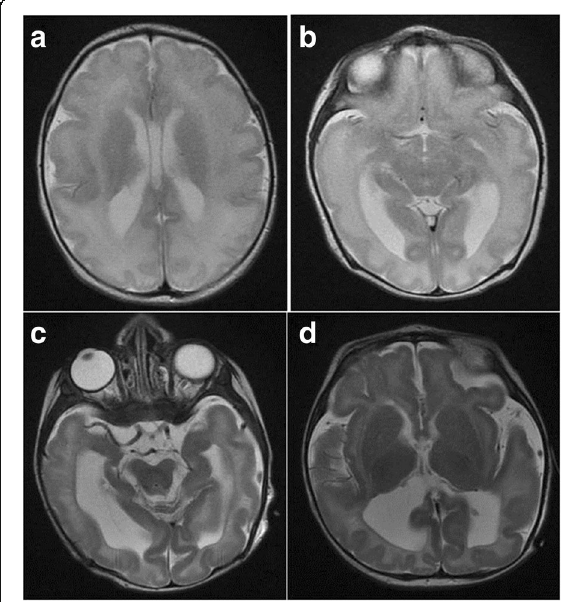
Fig. 2 T2-weighted axial images of the cerebrum showing diffuse hyperintensity and atrophy of white matter ( a , b , c , d ), dilated ventricles ( b , c , d ), enlarged subarachnoid space ( c , d ), and partial agenesis of the corpus callosum (absence of splenium) ( d